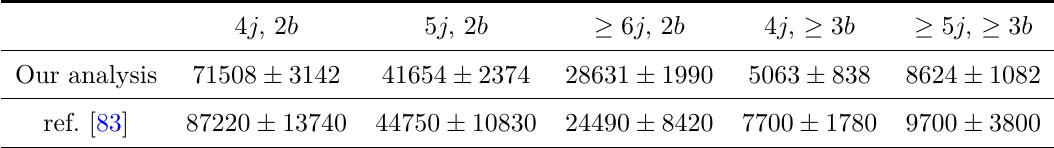
√ s = 8 TeV and 20 . 3 fb − 1 obtained